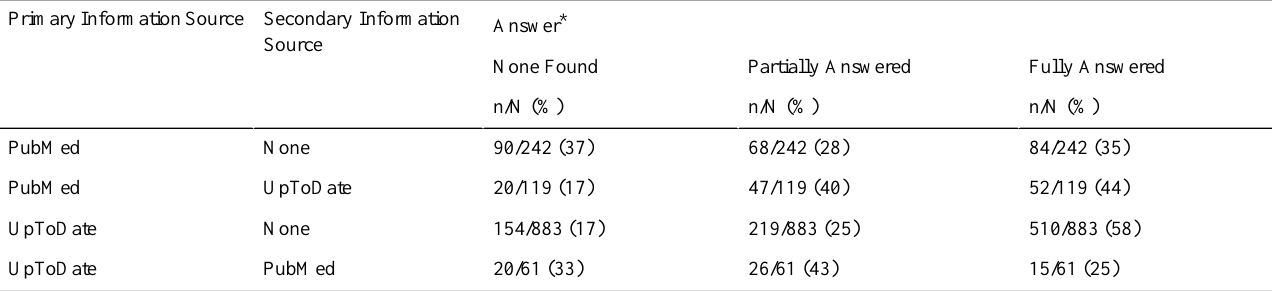
Table 2. Comparison of answers to questions sent to a single database and to both databases (N = 1305)